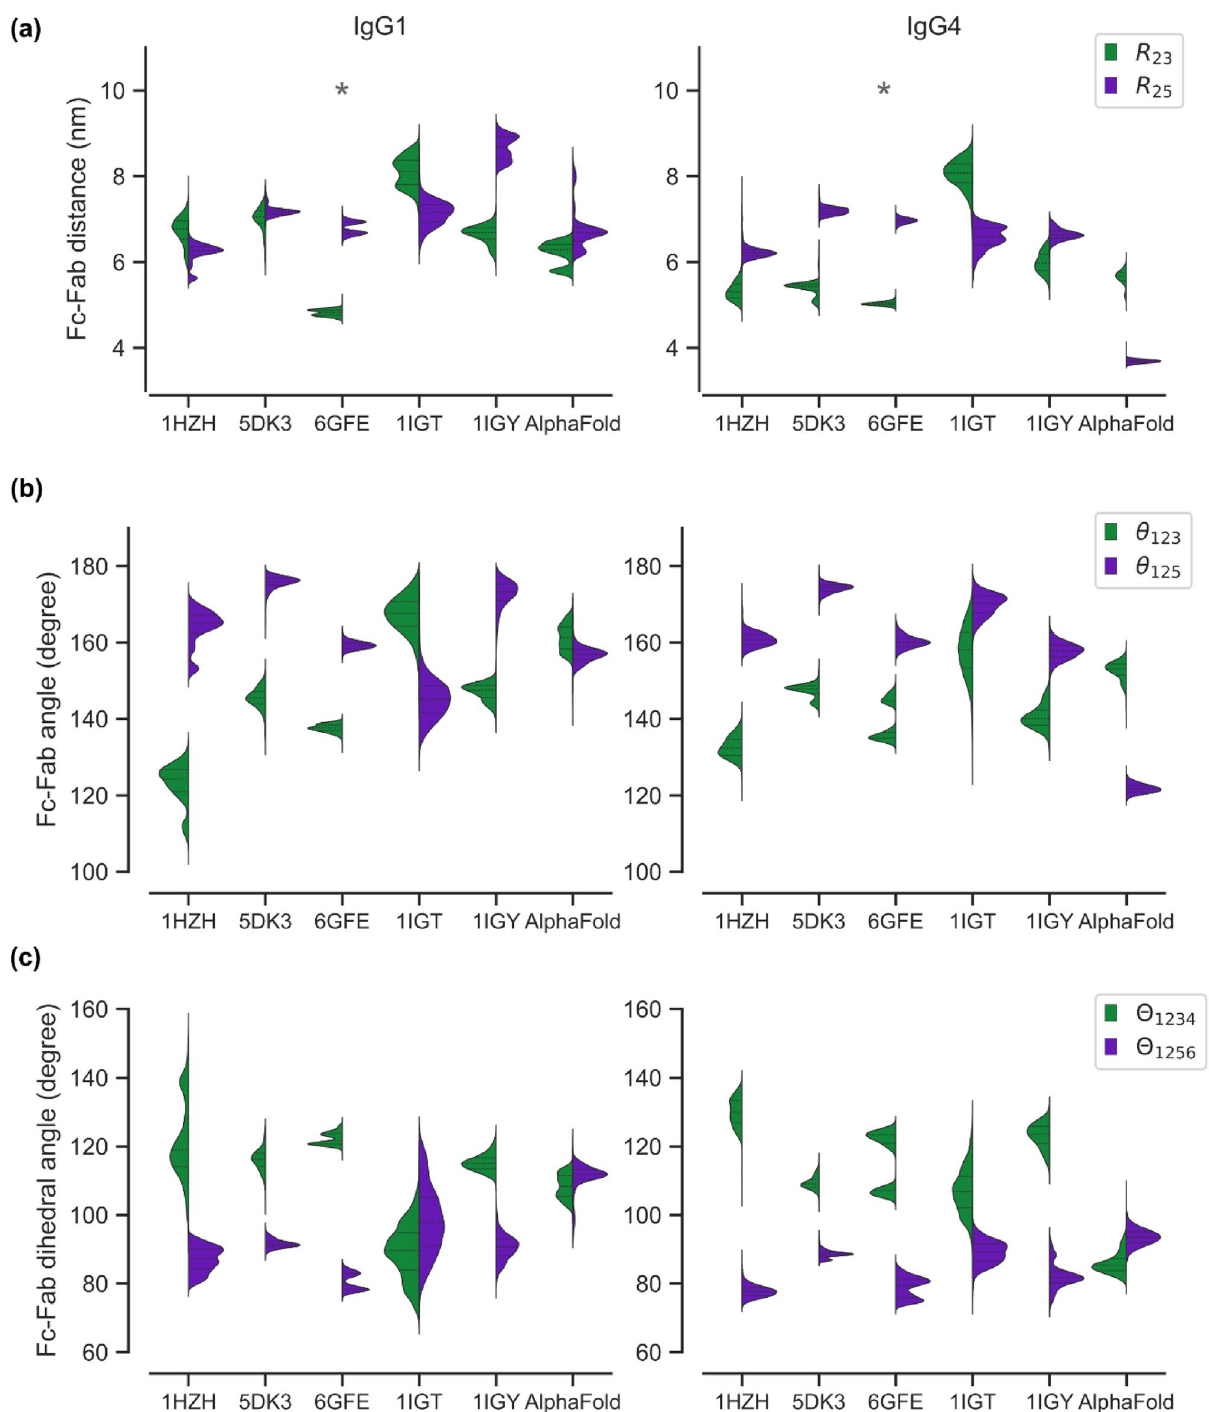
Figure 6. Comparison IgG1 and IgG4 dynamics for six different starting structures. In addition to the AlphaFold generated structure, five other initial conformations of the antibodies were generated from crystal structures (1HZH, 1IGT, 1IGY, 5DK3 and 6GFE) using homology modeling. Data shown correspond to duplicate implicit solvent simulations run for at least 500 ns. The violin plots in panels ( a )–( c ) show the distributions of Fc–Fab distances ( R 23 and R 25 ), Fc–Fab angles ( θ 123 and θ 125 ), and Fc–Fab dihedral angles ( (cid:31) 1234 and (cid:31) 1256 ), respectively, computed for the 6-bead model show in Fig. 2b. The asterisk marks the 6GFE structure that shows nearly identical joint distributions for IgG1 and